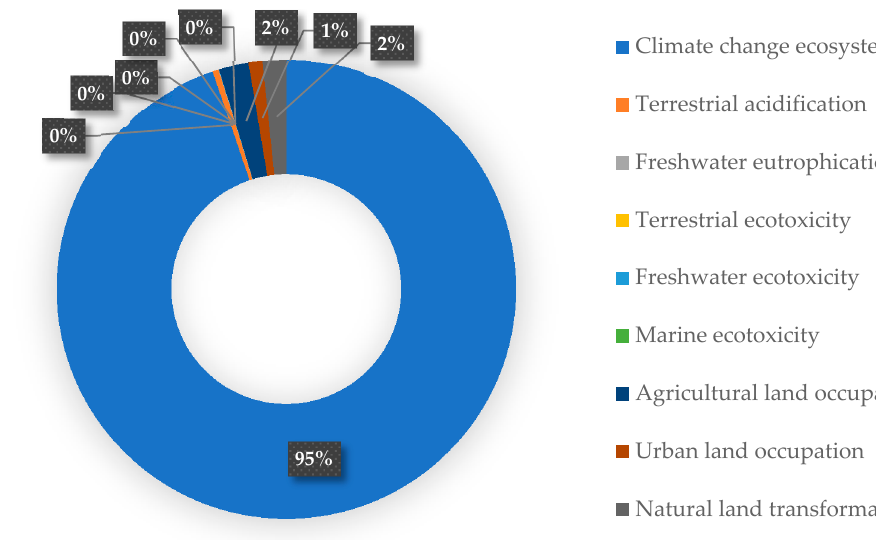
Figure 10. Contribution of each impact category to the total ecosystem damage (species.yr) of 1 kg of SPF-reinforced sago starch composite takeout food container.